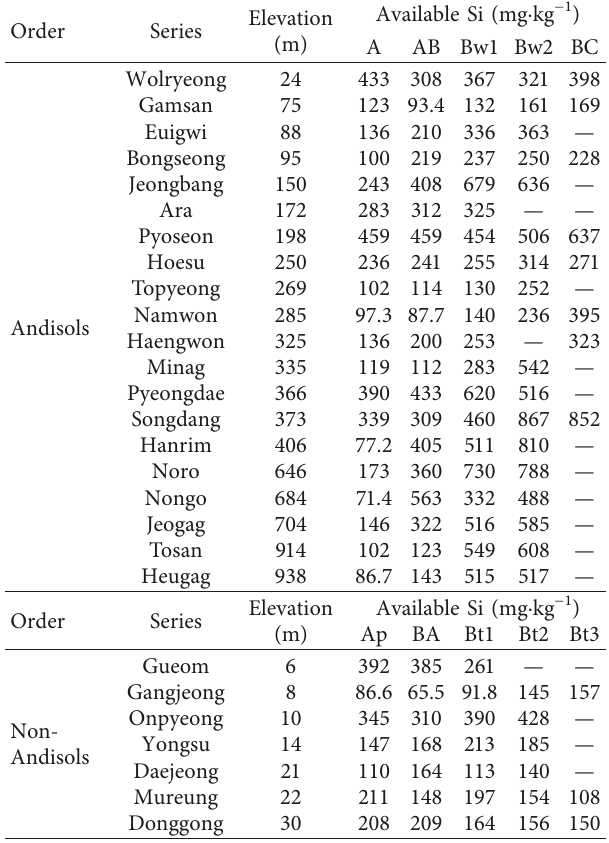
Table 2: Comparison of the available Si content of typifying pedons at different elevations on Jeju